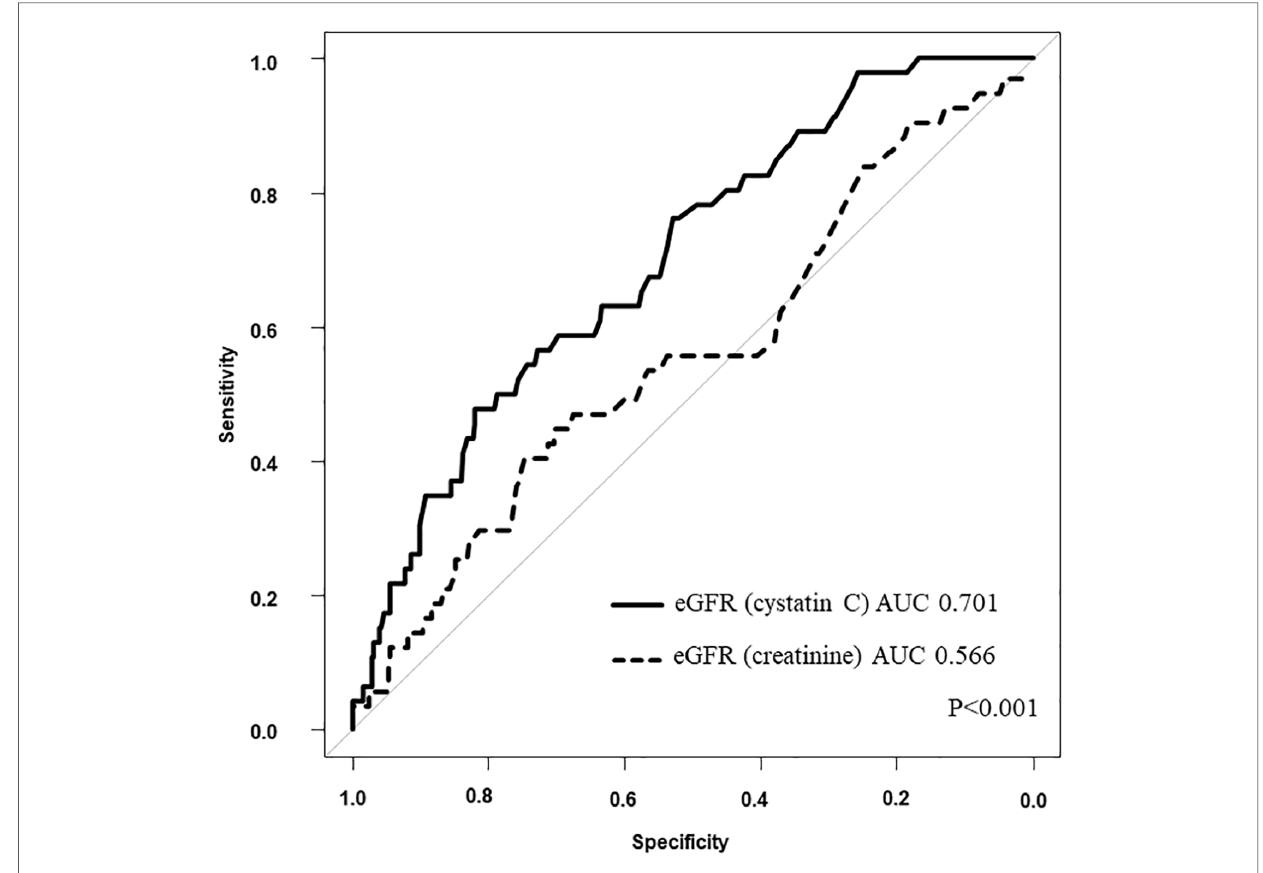
FIGURE 2 Comparison between eGFR (cystatin C) and eGFR (creatinine). AUC, area under the curve; eGFR, estimated glomerular fi ltration rate.